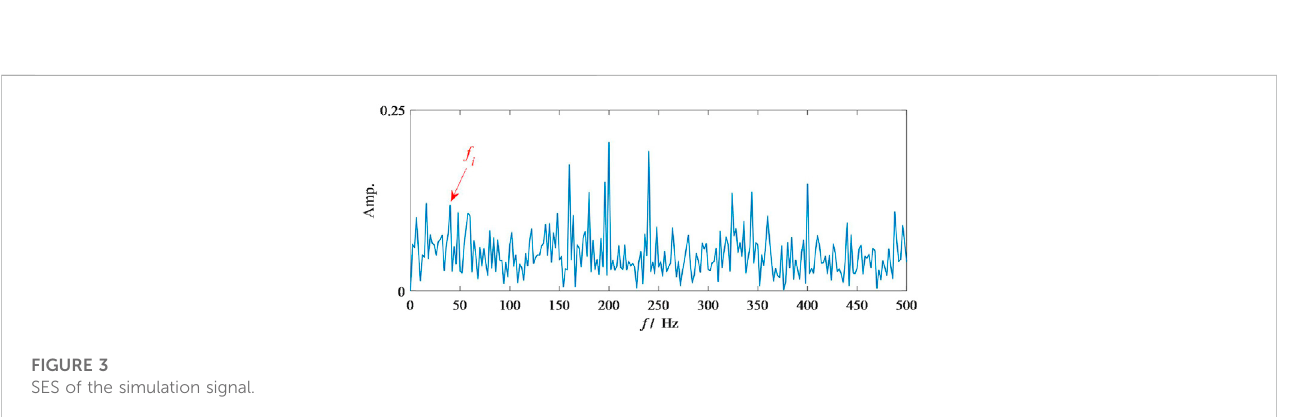
FIGURE 3 SES of the simulation